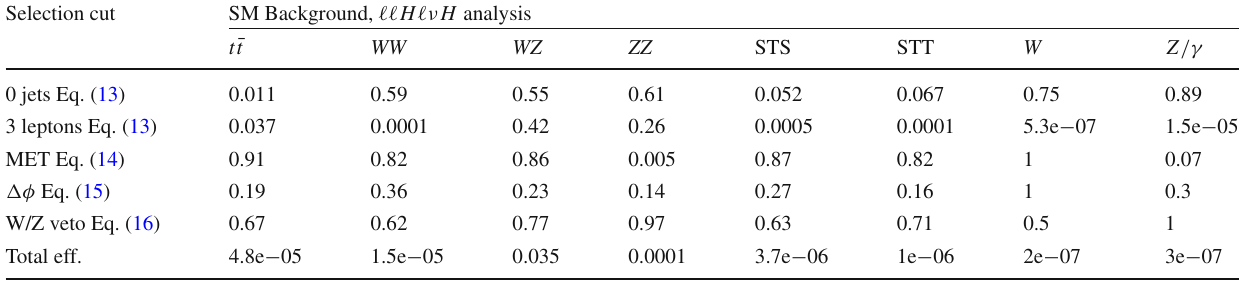
Table 8 Background selection efficiencies and the total efficiency for each background. STS and STT denote the single top s and t channels, respectively Selection cut